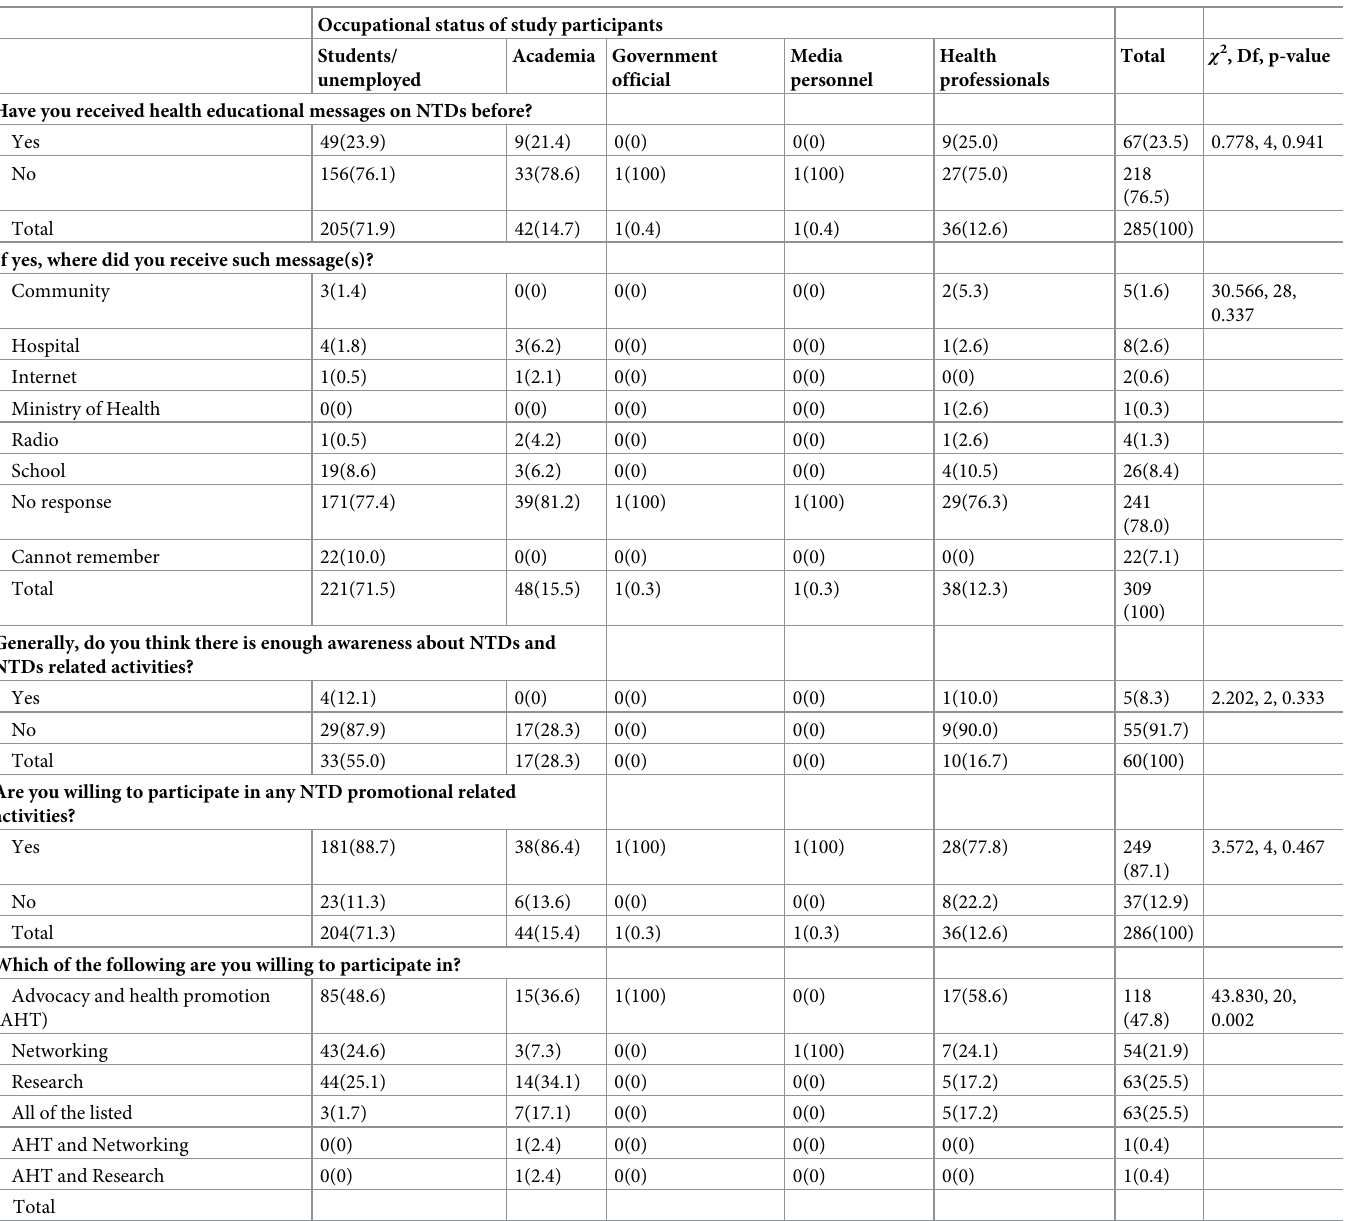
Table 5. Perception of attendees about public awareness on NTDs as a disease and other NTDs related